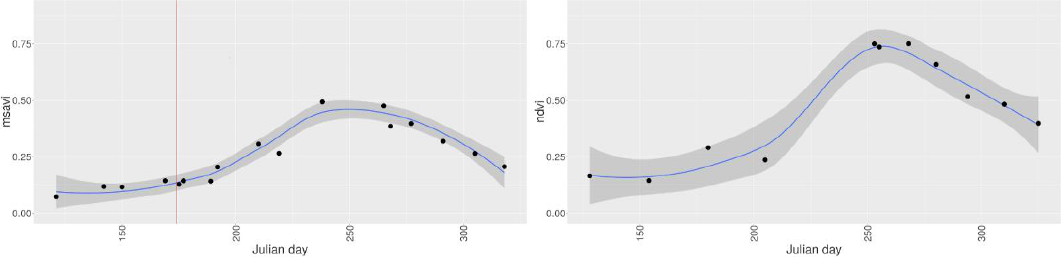
Figure 6. Temporal progression of vegetation indices (average (blue line) and standard deviation (shaded)) for a single crop field based on all the VHSR satellite images (from WV-2, WV-3, QuickBird, and GeoEye) for a whole year processed in the workflow. MSAVI for a cotton field in Sukumba, Mali for the year 2014, with a red vertical line indicating the sowing date ( left ), and NDVI for a soybean field in Kofa, Nigeria, for the year 2015 ( right ).